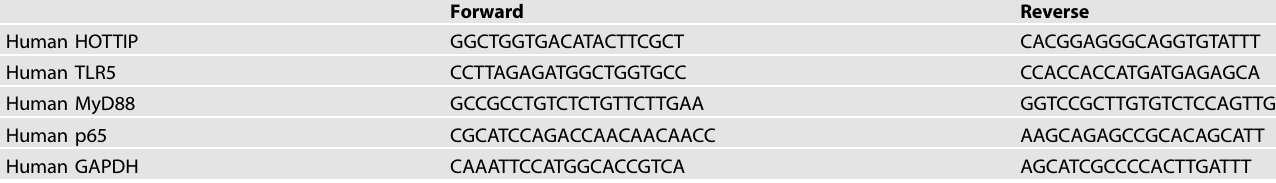
Table 1. The primer sequences utilized in real-time PCR